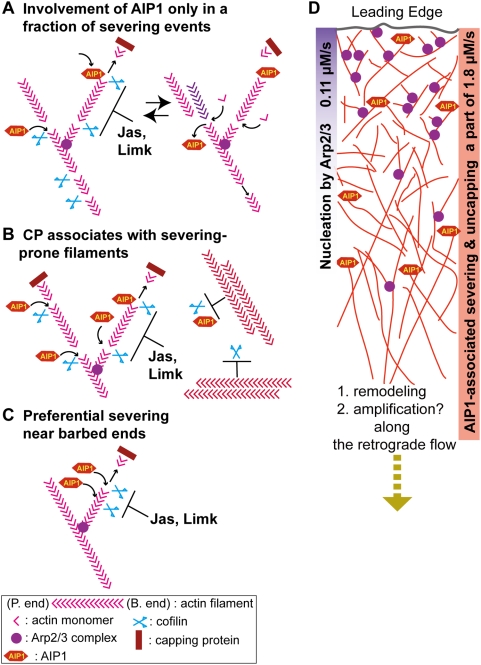
Models for mode and function of AIP1-associated filament disruption.(A) AIP1 may be associated with only a fraction of filament severing events within the network. (B) CP may preferentially associate with the dynamic filaments prone to AIP-mediated filament severing/disruption. We estimate that roughly a half of F-actin is stabilized in lamellipodia of XTC cells. (C) Alternatively, AIP1-associate filament severing/disruption may occur preferentially at the proximity of the barbed end within a single filament. (D) Cooperation of nucleation and filament severing/disruption to facilitate leading edge protrusion. Release of free barbed ends from AIP1-associated filament disruption processes may amplify the Arp2/3 complex-initiated actin nucleation increase at the leading edge by repeatedly acting along the retrograde flow. The severing and end-to-end annealing may also be relevant to actin remodeling activities that confer filament angle and length alternation along the aging of network seen in published electron micrographs [10], [48].